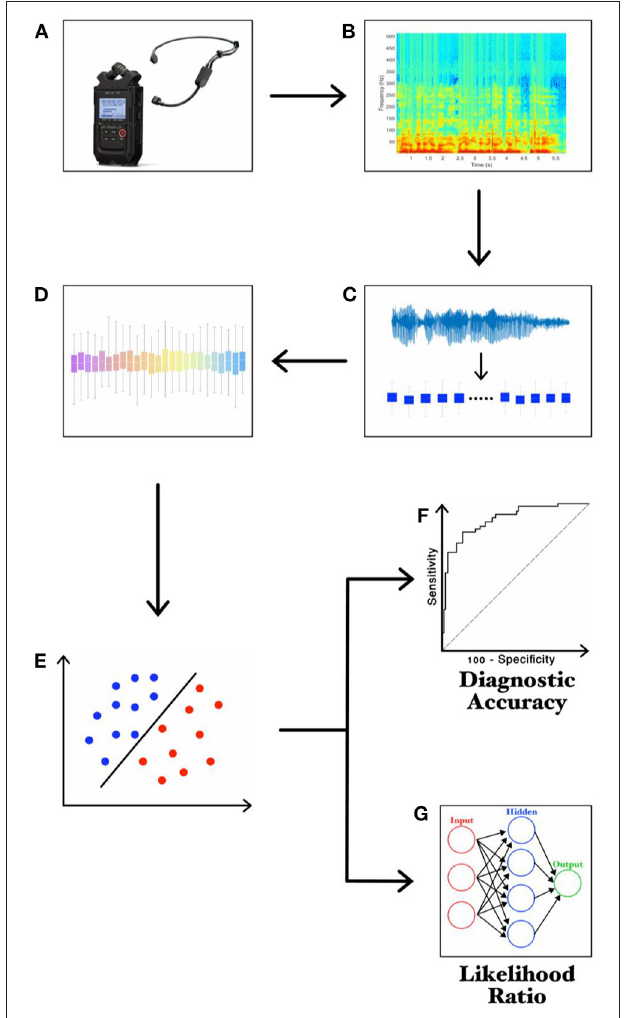
FIGURE 1 | Experimental design. (A) recording of voice samples through a high-definition audio recorder; (B) narrow-band spectrogram of the acoustic voice signal; (C) feature extraction; (D) feature selection; (E) feature classification; (F) ROC curve analysis; (G) LR values calculated through